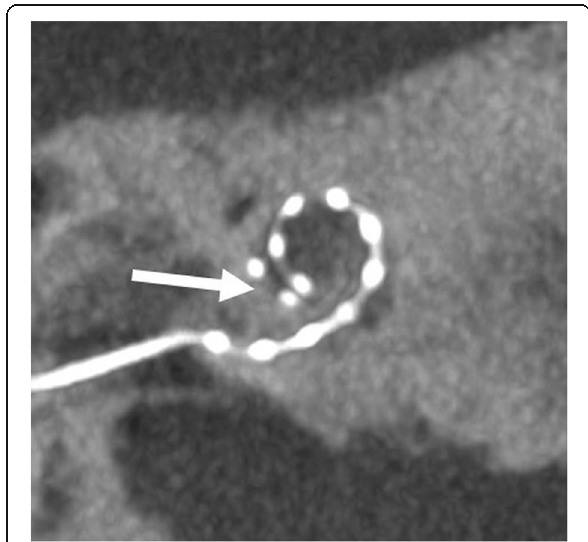
Basal fold-over (Fig. 30)